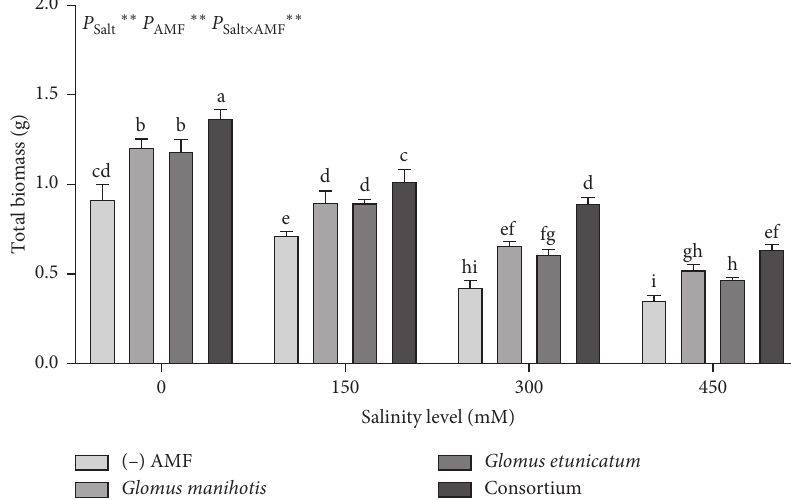
Figure 4: Effects of AMF inoculation on the biomass of L. leucocephala seedlings at different NaCl stress. AMF: arbuscular mycorrhizal fungi. ∗ : significant at 0.01 ≤ P ≤ 0 . 05; ∗∗ : significant at P ≤ 0 . 01. Bars that do not share a letter are significantly different at P ≤ 0 . 05.